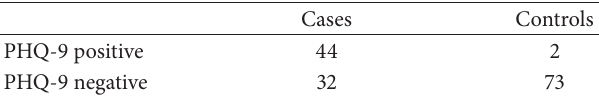
Table 1: Sensitivity and specificity of the PHQ-9 categorical algo-